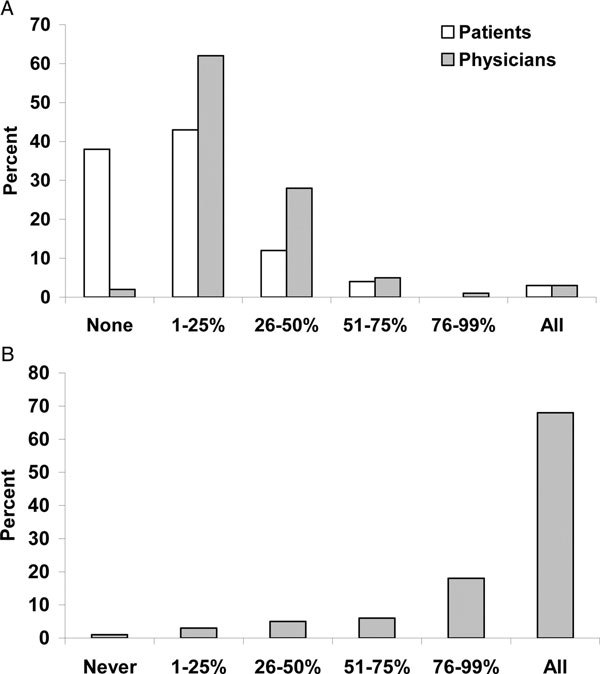
(A) Frequency of discussions about short- and long-term side effects of asthma medications. Physician questions: When you prescribe asthma medications to your patients, how often do you discuss local side effects such as oral thrush, pharyngitis or hoarseness? When you prescribe asthma medications to your patients, how often do you discuss the potential for systemic side effects such as osteoporosis, cataracts or glaucoma? Patient questions: How often do you or did you discuss short-term side effects of your asthma medication related to your mouth or throat--such as fungal infection, sore throat or hoarseness--with your doctor or health care professional? How often do you or did you discuss long-term side effects of your asthma medication--such as weight gain, weakening of the bones or changing bone density, cataracts or glaucoma--with your doctor or other health care professional? (B) Frequency of physicians informing patients of being prescribed an ICS. When you prescribe inhaled corticosteroids alone or in combination, on average, what percent of the time do you tell your patients that they will be taking a steroid?